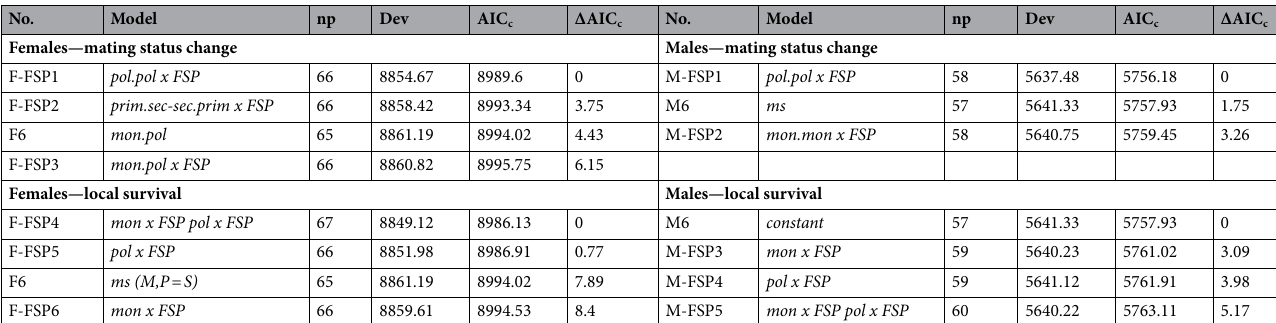
Table 2. Model selection to test the effect of frequency of social polygyny on the probabilities of mating status change and local survival probabilities of pied flycatcher females and males. For each model, we report the deviance, the number of estimable parameters ( np ), the Akaike Information Criterion corrected for small sample sizes (AIC c ) and the difference in AIC c between the current model and best model with the lowest AIC c of the current parameter (ΔAIC c ). Model notation: pol.pol , P of mating status change from “pol to pol” (females: primary or secondary, males: polygynous), mon.mon , P of “mon to mon”, prim.sec-sec.prim , same P of “prim to sec” and “sec to prim”, mon.pol , this is the null model without any effect of FSP on the P of mating status change (corresponding to mon.pol1 in Table 1), ms , this is the null model without any effect of FSP on the P of survival (see ms in Table 1), mon , monogamous, pol , polygamous, prim , primary, sec , secondary, x FSP , that depends on the frequency of social polygyny, constant , no effect. Note that in Females — Local survival , although not explicitly stated, all the models include the additive effect of age (see Table